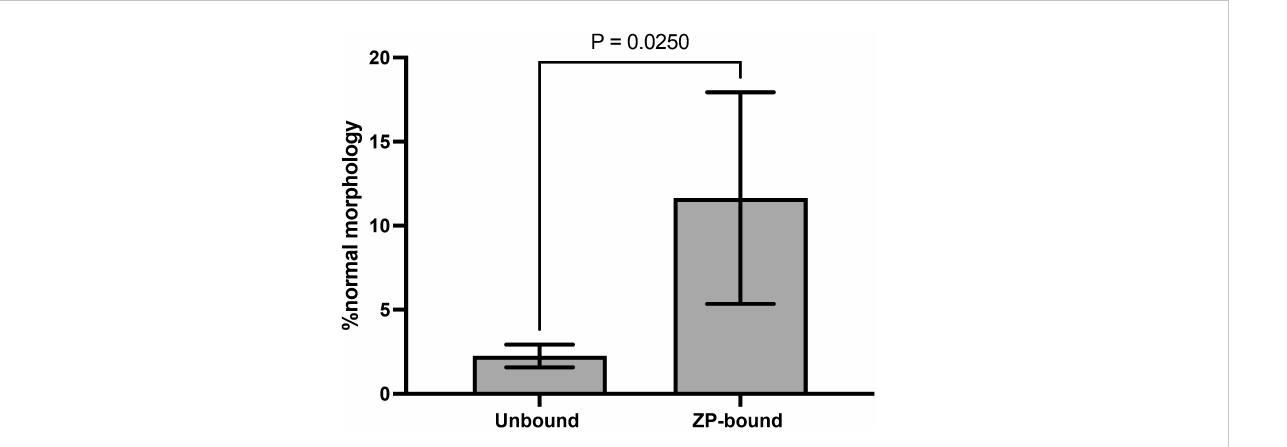
FIGURE 4 Morphology evaluation of ZP-bound and unbound spermatozoa. ZP-bound and unbound spermatozoa were classi fi ed as having normal or abnormal morphology according to the WHO strict criteria. All data are represented as mean ± SD (n=5,